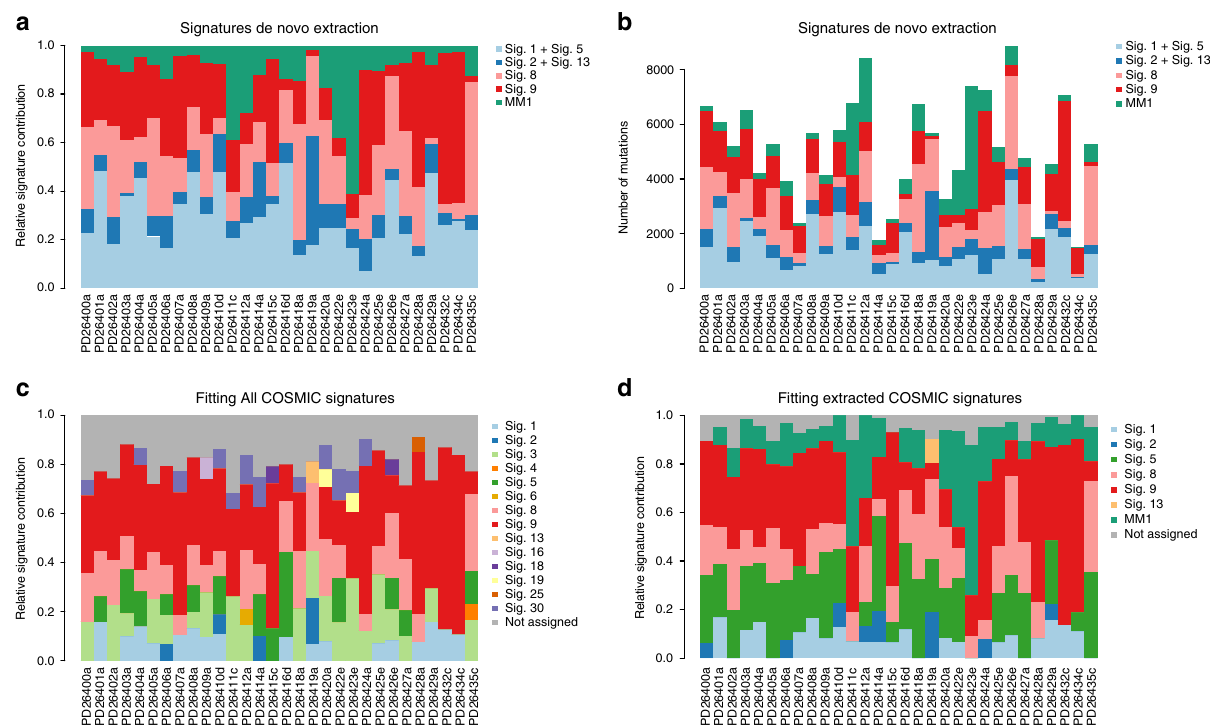
Fig. 1 Mutational signature de novo extraction vs. fi tting. a , b The Alexandrov et al. NNMF framework 6,7 . From the 96-mutational classes, NNMF extracted